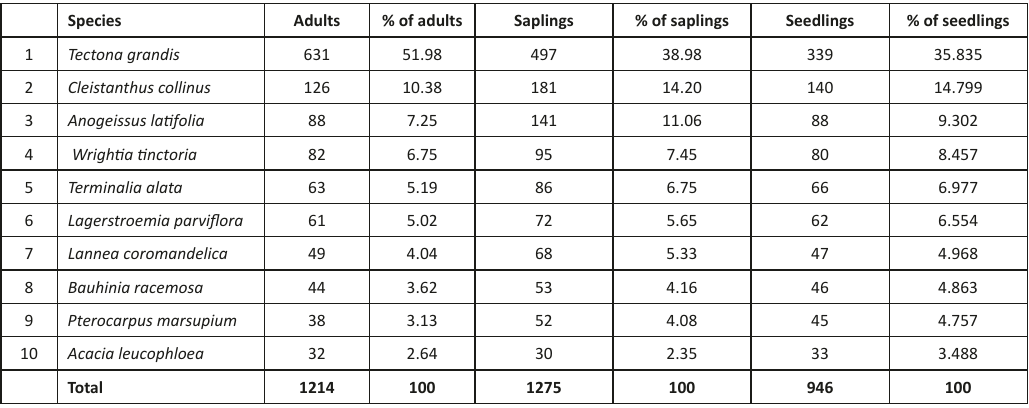
Table 5. Community structure of predominant species.